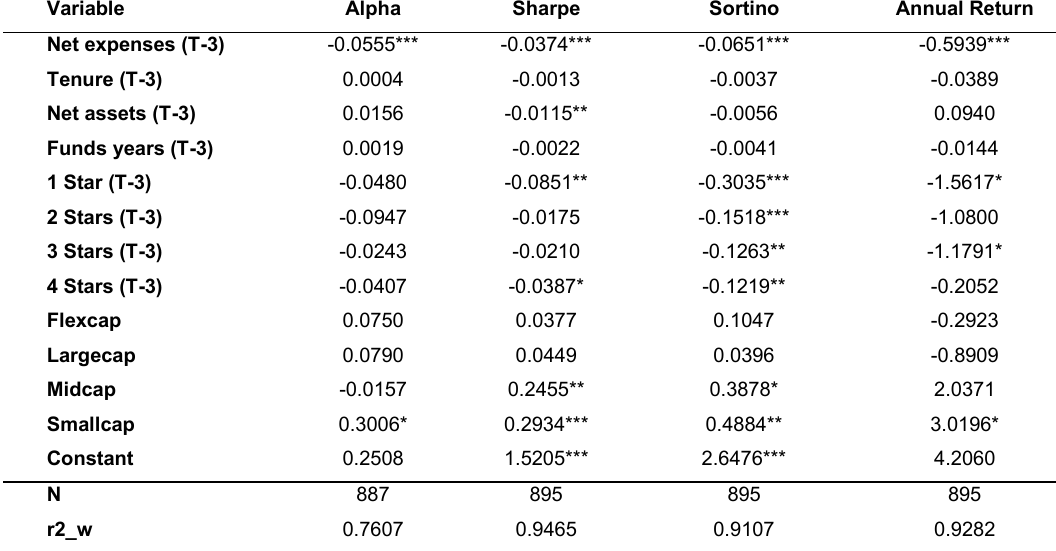
Table 4 . Regression in the panel data, of the expense ratio (T-3) of the funds with respect to their performance with star rating control variables (T-3), with random